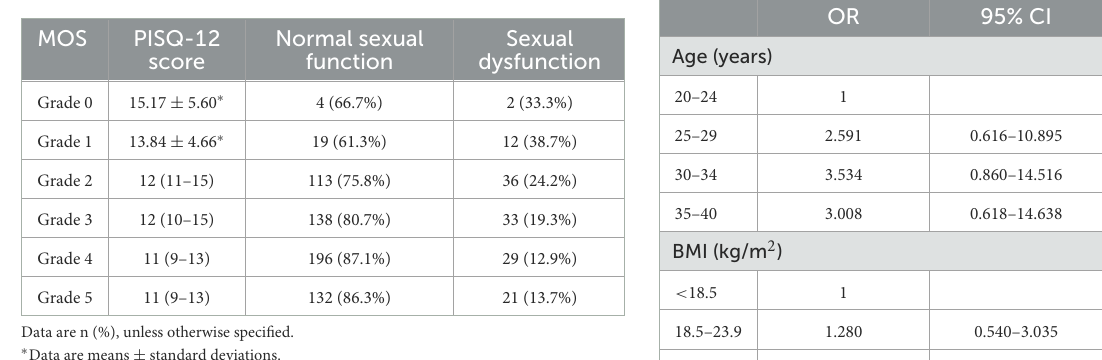
TABLE 3 Ordinal logistic regression analysis of PISQ-12 score